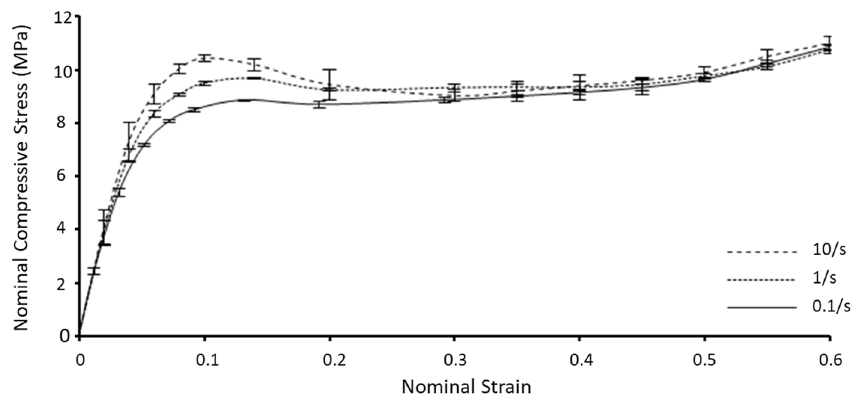
8 Figure 3. Schematic drawings of the types of chip formation are presented alongside the typical cutting force-tool displacement curves that correspond to each type of chip formation. 3. Results 3.1. Uniaxial Dynamic Compression Tests Experimentally measured nominal stress-nominal strain curves for the dynamic uni- axial compression testing of PU20 are shown in Figure 4, with associated Young’s modu- lus and yield stress (mean ± SD (range)) shown in Table 5. The measured values for = (cid:3052)